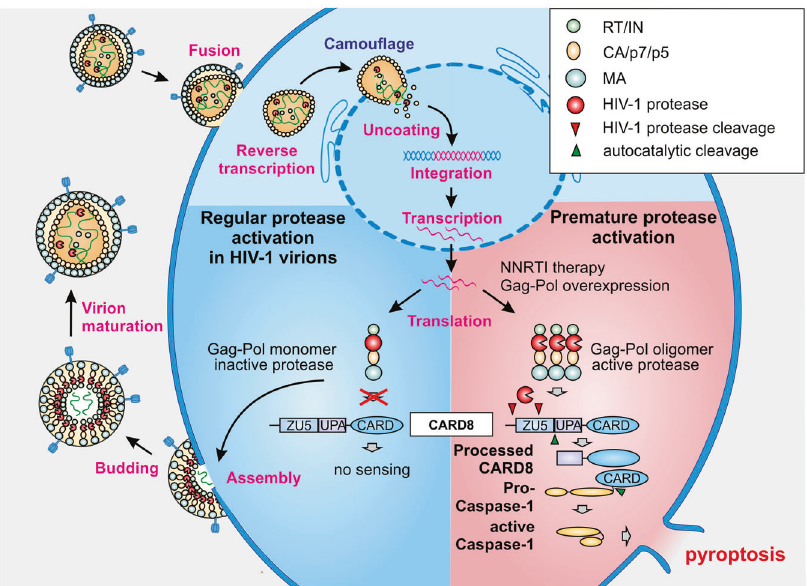
Fig. 1 Activation of the CARD8 in fl ammasome by premature, intracellular activation of the HIV-1 protease. During regular HIV-1 infection incoming capsids are uncoated at the nuclear pore or even in the nucleus, allowing the delivery of the reverse-transcribed linear dsDNA for proviral integration into the host genome. Subsequent transcription and translation lead to expression of the Gag-Pol precursor polyprotein. Assembly and oligomerization of the polyprotein in the budding virion activates the protease, which processes and matures the virion. During NNRTI therapy or arti fi cial Gag-Pol expression, the polyprotein accumulates in the cytoplasm leading to premature viral protease activity. Subsequent cleavage of CARD8 leads to the recruitment of pro-caspase-1, generation of active caspase-1, and ultimately pyroptotic death of HIV-1-infected cells. RT reverse transcriptase, IN integrase, CA capsid protein, MA matrix